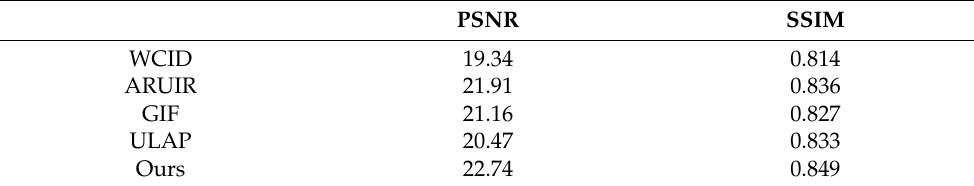
Table 5. Full reference